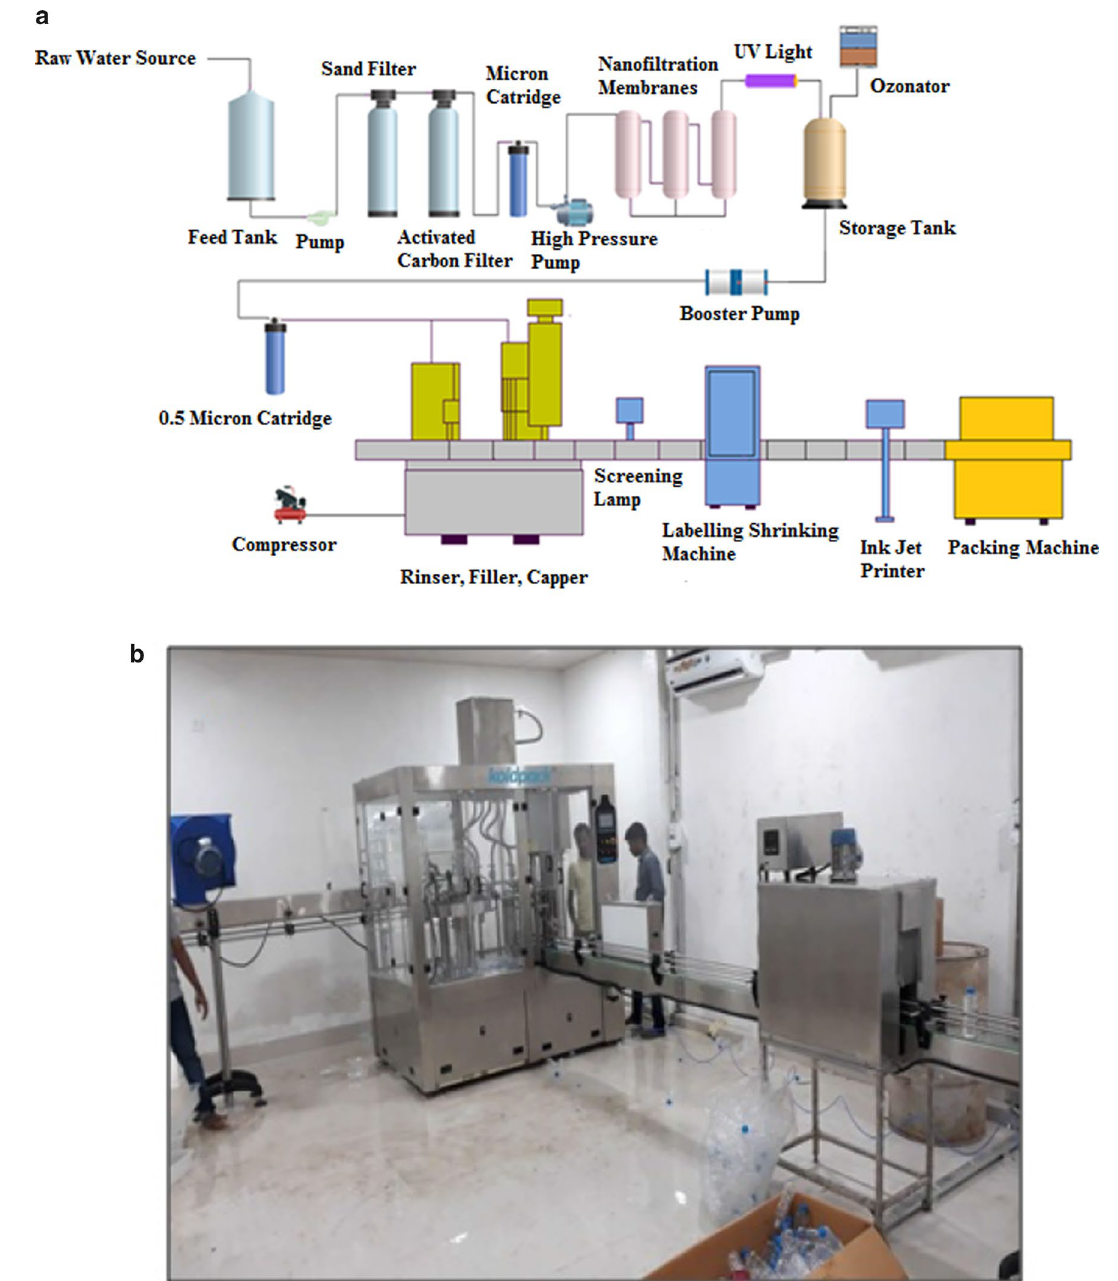
Fig. 12 Schematic of a water purification pilot plant along with bottling unit and b photograph of bottling